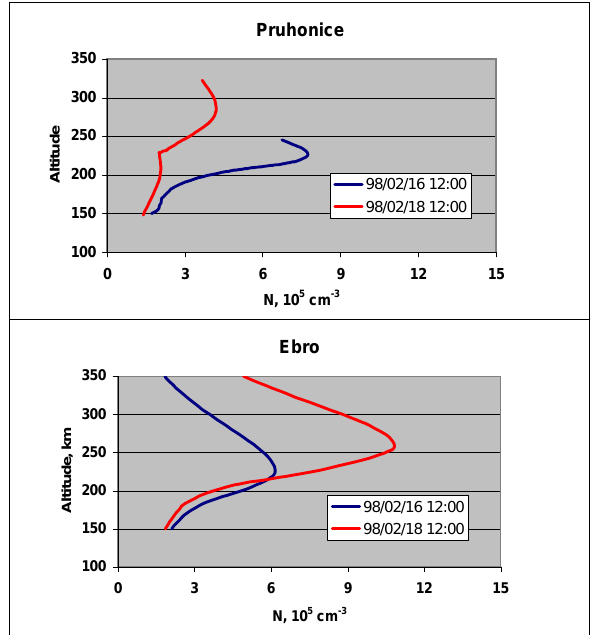
Fig. 5. The noontime electron density profiles in the F-region (150–350km) for the storm of February 1998, one day before the storm onset (blue line) and during the storm main phase (red line) for Pruhonice and Ebro. Altitude in km, electron density N in 10 5 cm − 3